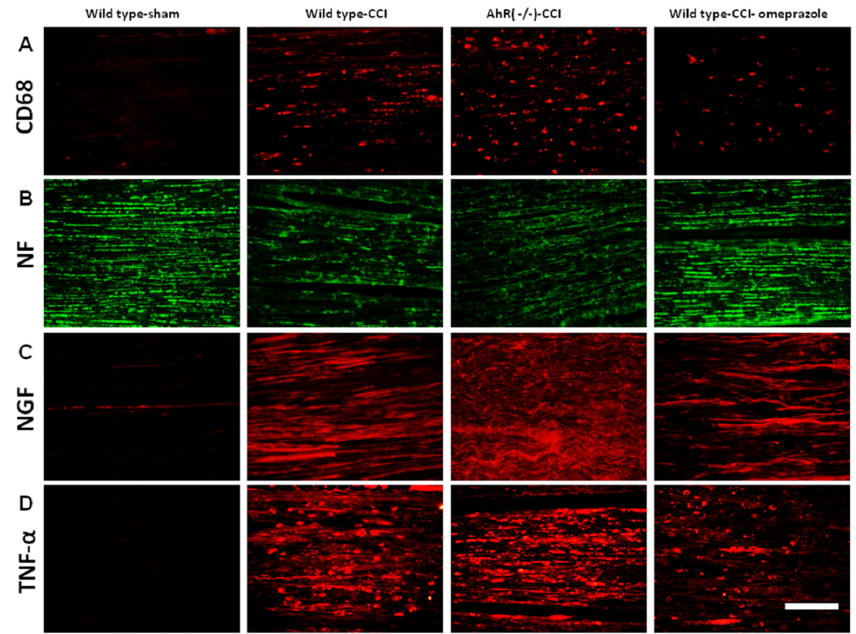
Figure 6. The expression of nerve degeneration and the associated inflammatory proteins in animals subjected to CCI 28 days after injury. ( A ) The expression of CD 68 in the distal end of nerve measured in different treatment groups. ( B ) The expression of neurofilament in different treatment groups. ( C ) The expression of NGF in different treatment groups. ( D ) The expression of TNF- α in different treatment groups. N = 6, Bar length = 100 μ m; Wild type-sham; Wild type-CCI; AhR ( − / − )- CCI; Wild type-CCI-omeprazole: see text.